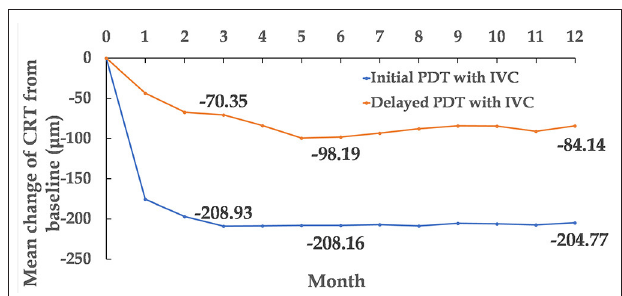
FIGURE 4 | Mean change of CRT from baseline to month 12. CRT, central retinal thickness.